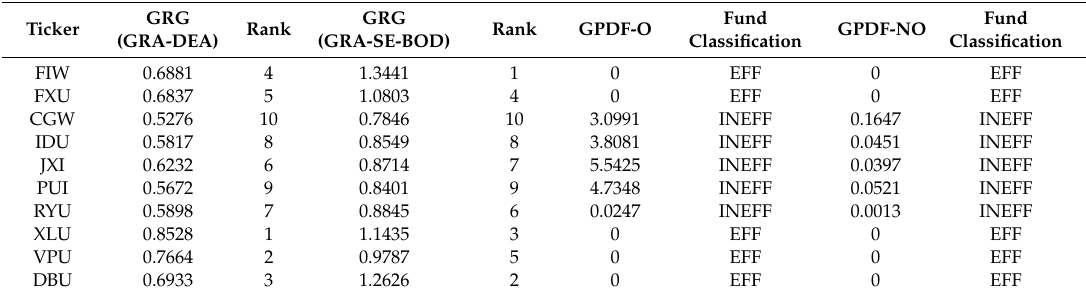
Table 3. Results of data envelopment analysis (DEA)-based grey relational analysis (GRA) and generalized proportional distance function (GPDF)